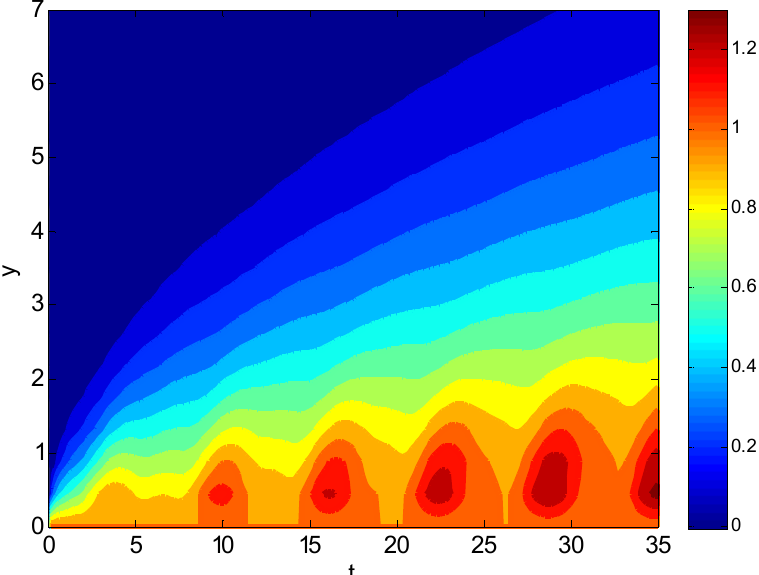
Figure 9. Contours of temperature profile for Stokes second problem.